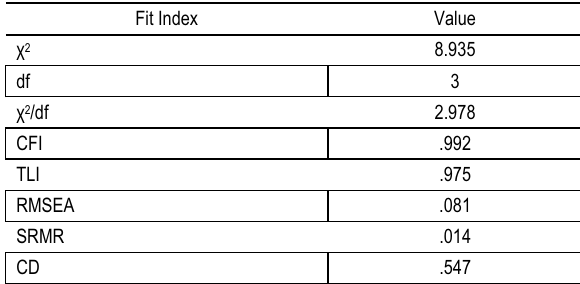
Table 4. Goodness of fit indices of the mediation